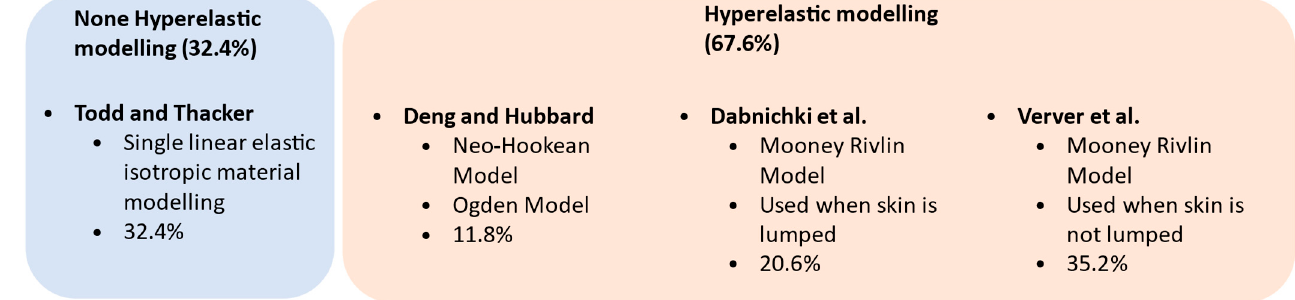
Figure 6. Skin material modeling options and the percentage of the method most used in the research papers included in this review [44,45,47,48].